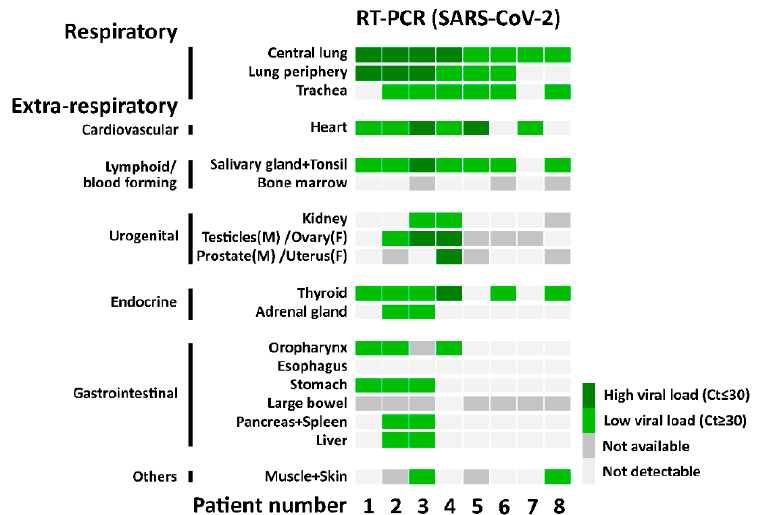
Figure 2. SARS-CoV-2 RNA detection with RT-PCR. The heatmap shows the results of the quanti- tative PCR detection of SARS-CoV-2 for each patient in all analyzed tissues. PCR detection of SARS-CoV-2 for each patient in all analyzed